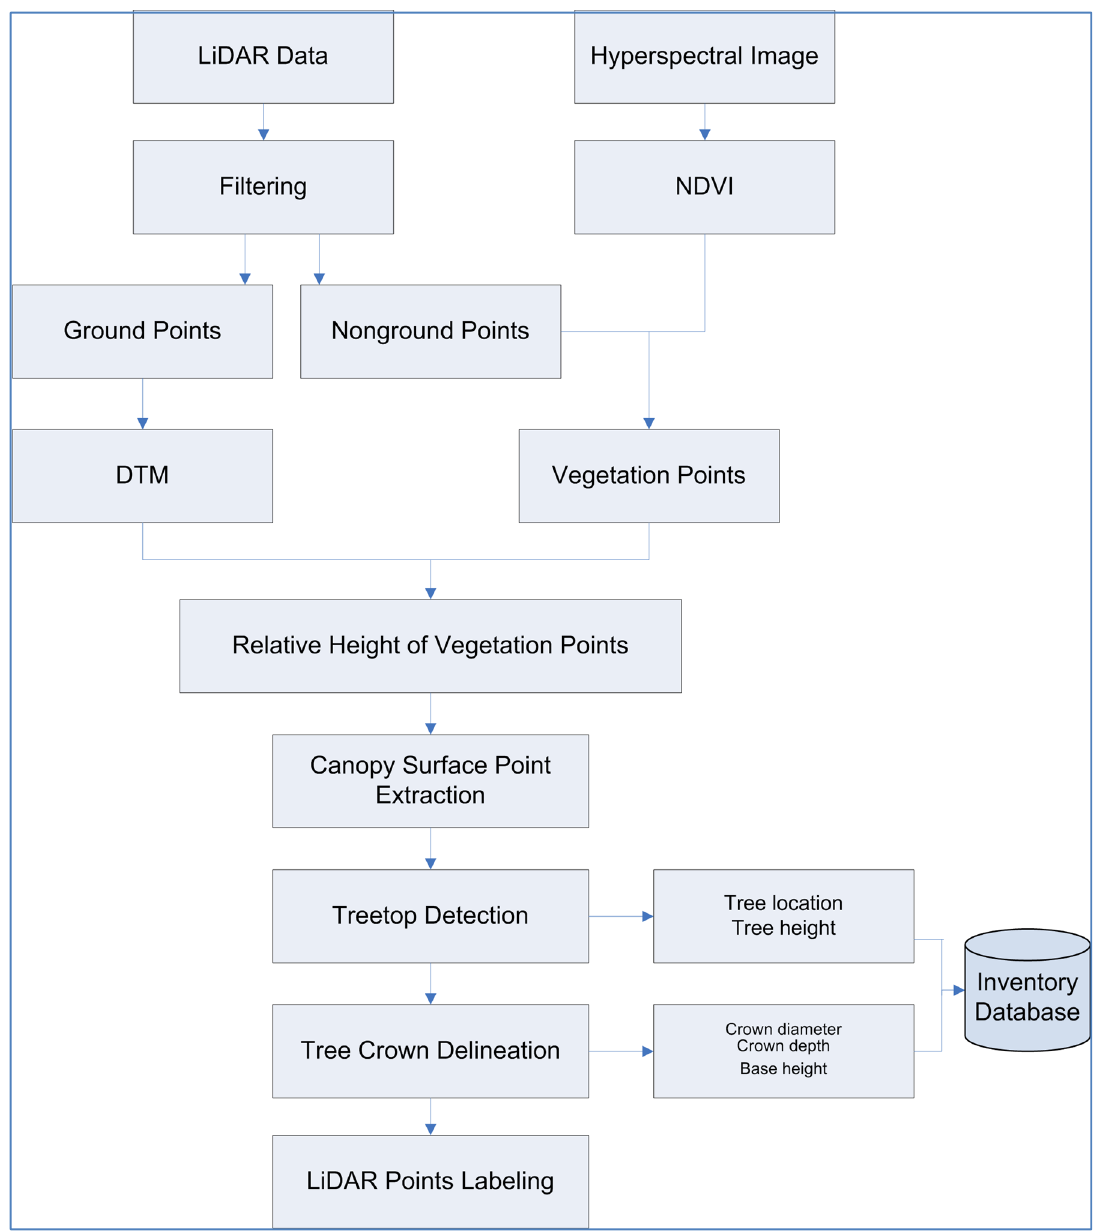
Figure 3. The designed framework to combine LiDAR and hyperspectral data for urban forest inventory at the individual tree